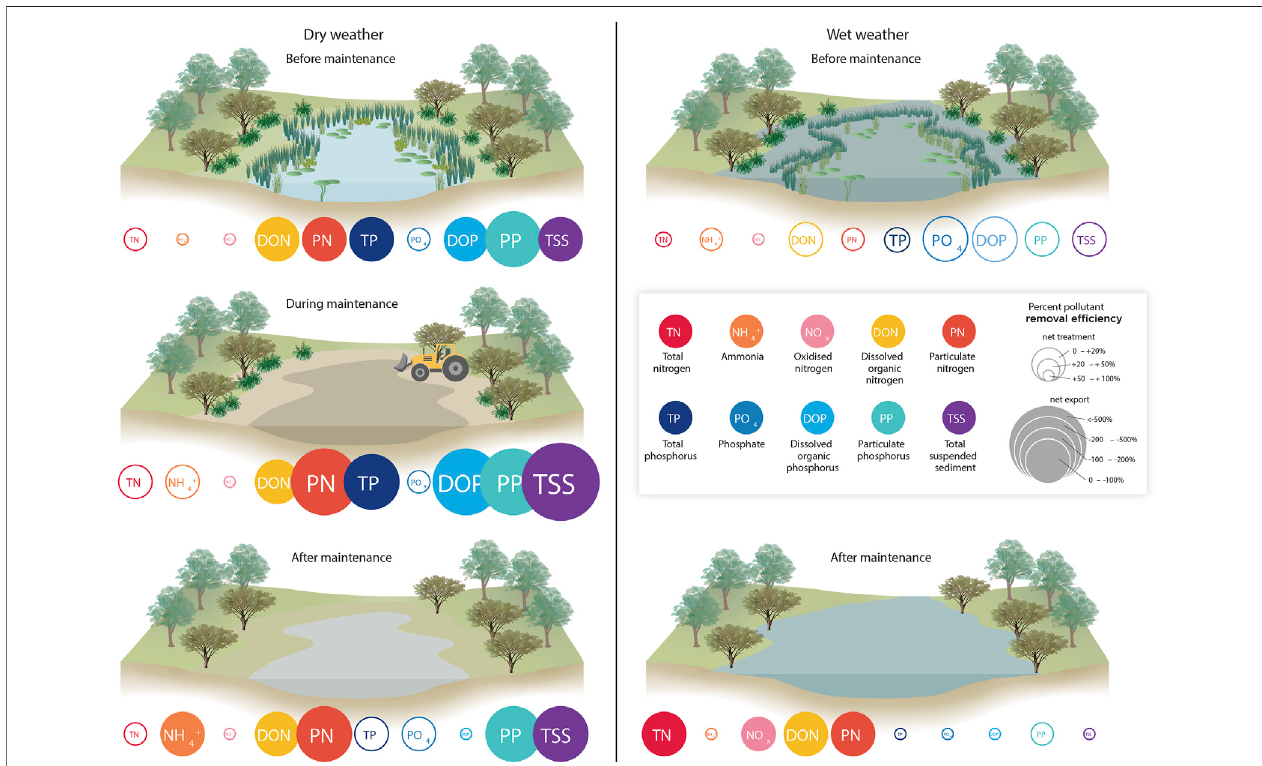
FIGURE 8 | Treatment dynamics of nitrogen, phosphorous and total sediment in the study CW before, during and after maintenance, during base fl ow and event fl ow conditions.